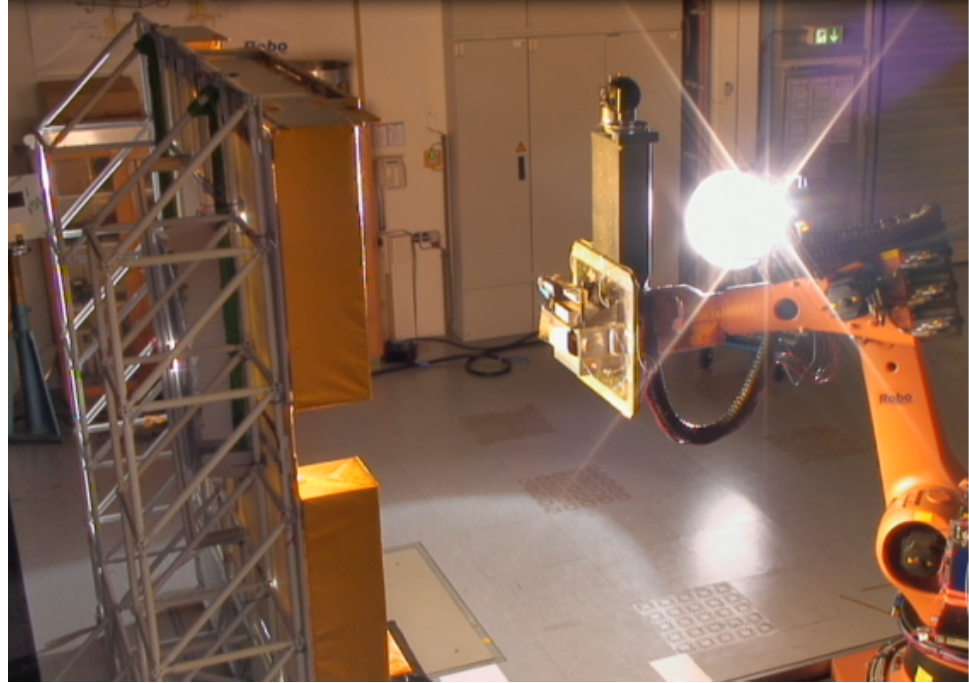
Figure 18. Left: target GEO mock up stationary on the laboratory floor. Right: sensors mounted on robot